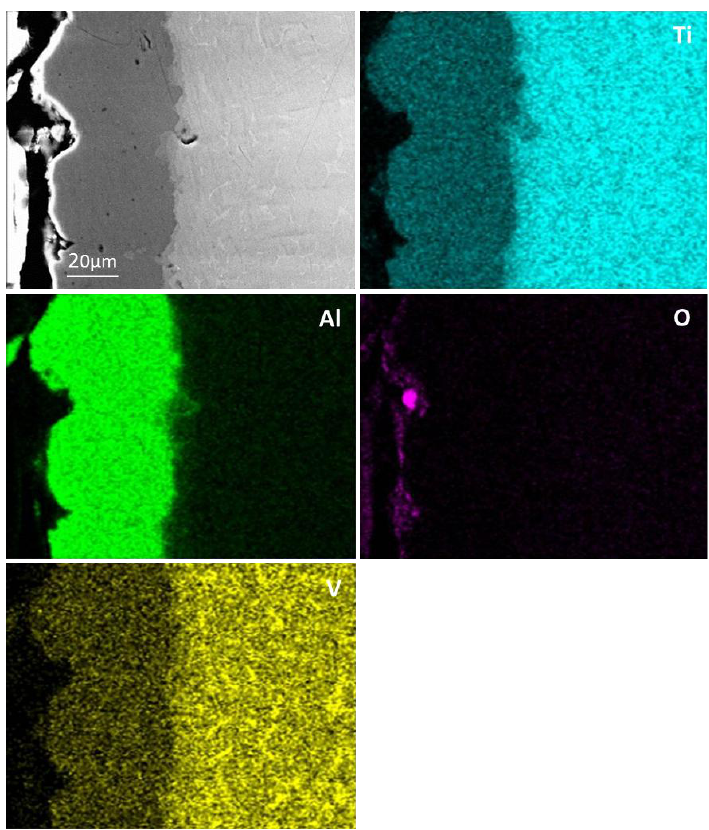
Figure 10. SEM image and EDS mapping for cross-sectioned Ti-6Al-4V aluminised at 1000 °C for 6 h.